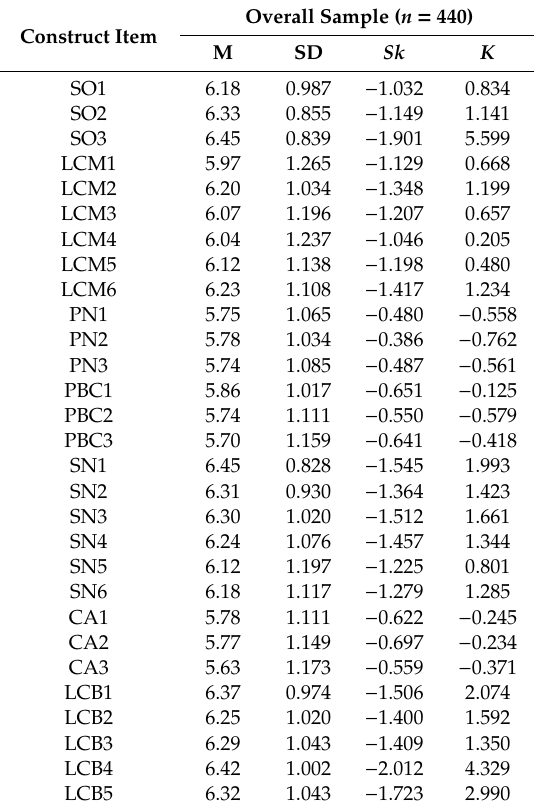
Table 5. Descriptive statistics of construct items.